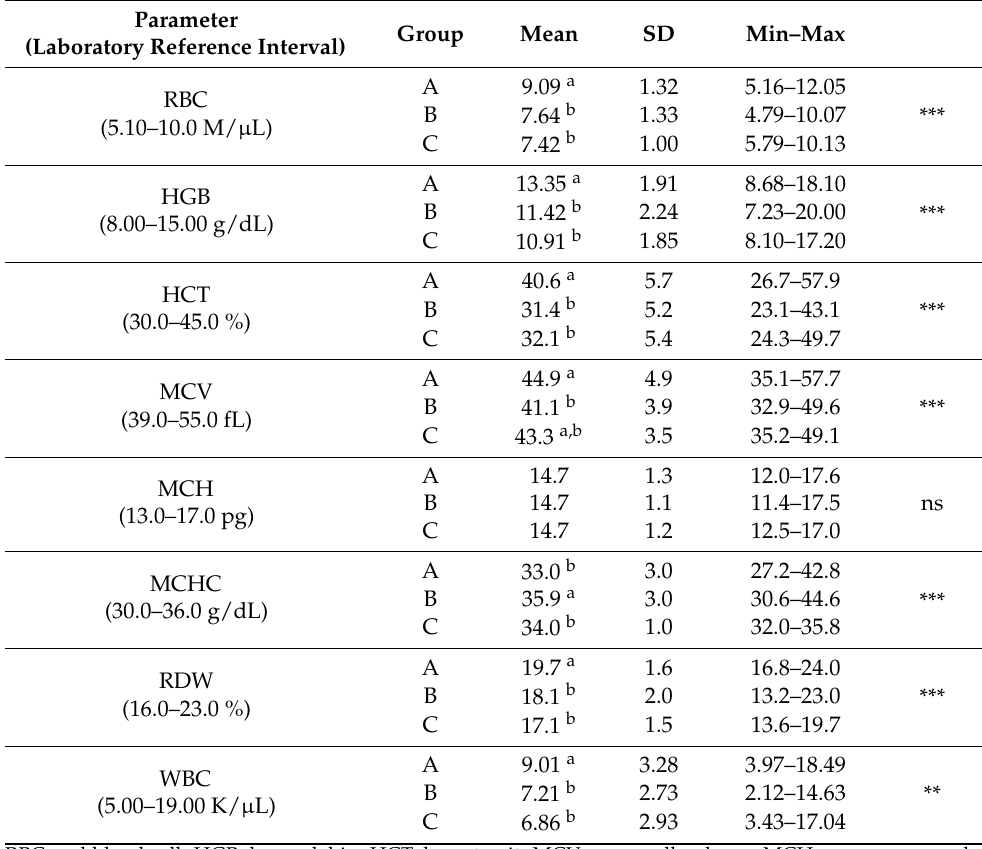
Table 1. Hematological parameters (mean ± SD; minimum and maximum values) evaluated in healthy donor cats before (group A, N = 78) and after (group B, N = 65) sedation and in whole blood donated units (group C, N =